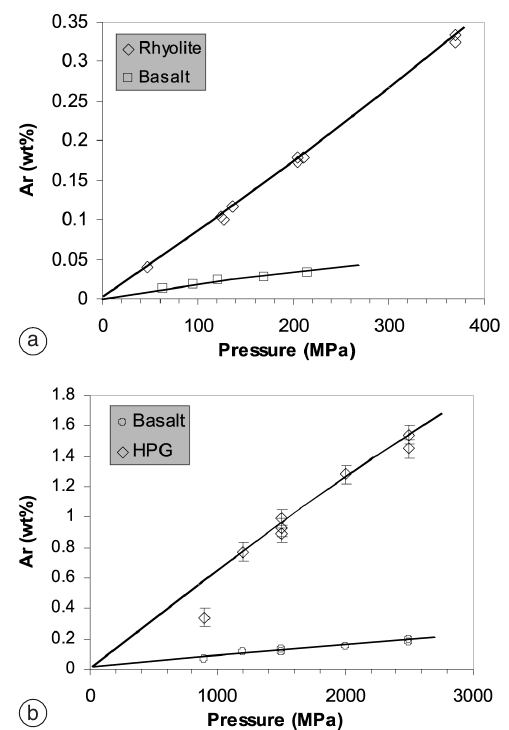
Fig. 2a,b. Dissolved Ar as a function of Ar pressure in a) rhyolite (800-900°C) and basalt (1200°C); b) haplogranite and basalt (1500°C). Data are from Car- roll and Stolper (1993) and White et al . (1989). Curves were calculated by using eq. (3.6) with pa- rameters given in table I. The linear relation between concentration and pressure, as well as the higher sol- ubilities in the acidic compositions, should be noted.